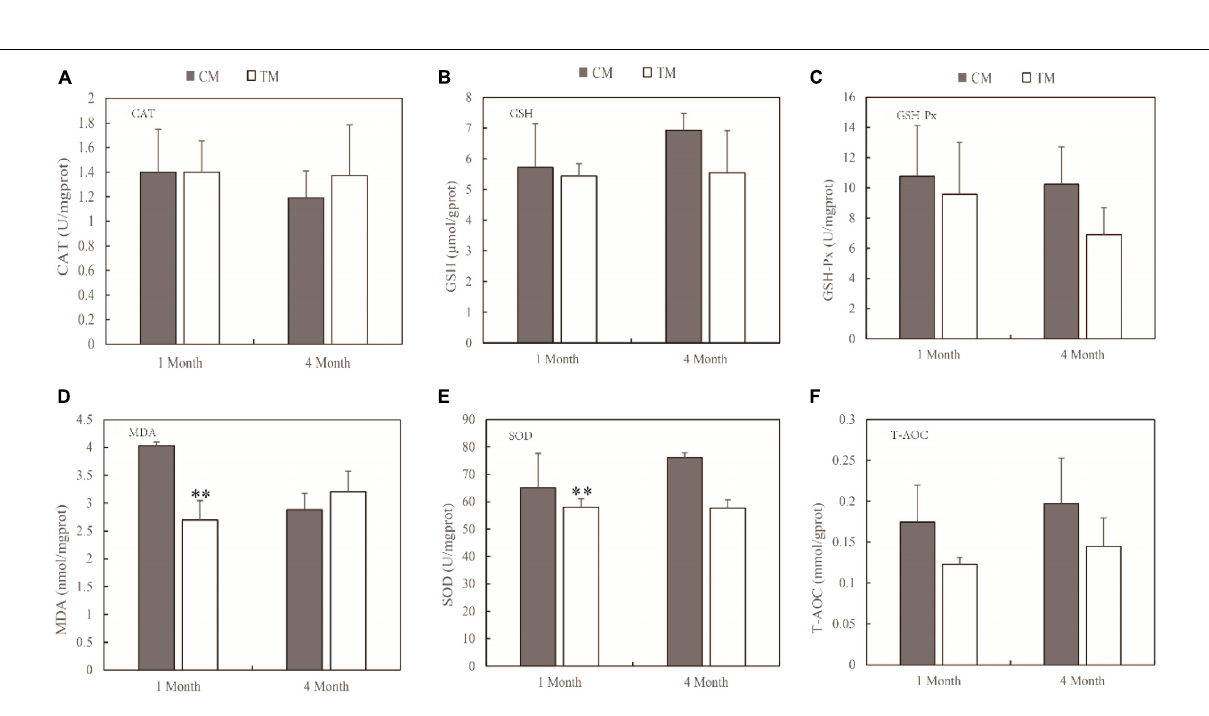
Frontiers in Microbiology |